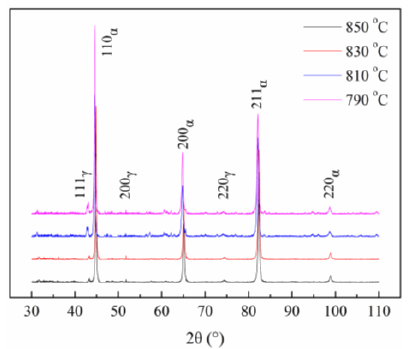
Figure 13. XRD (X-ray diffraction) spectra of samples varied with a finish rolling temperature from 850 ◦ C to 790 ◦